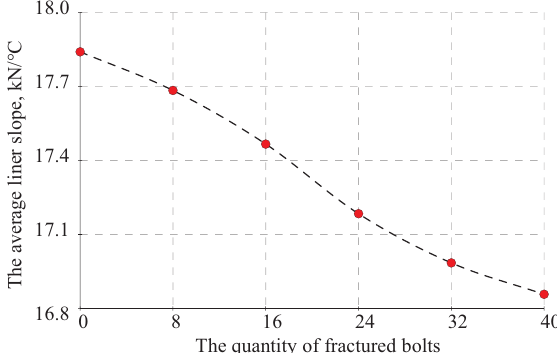
Figure 18. The influence of fracture